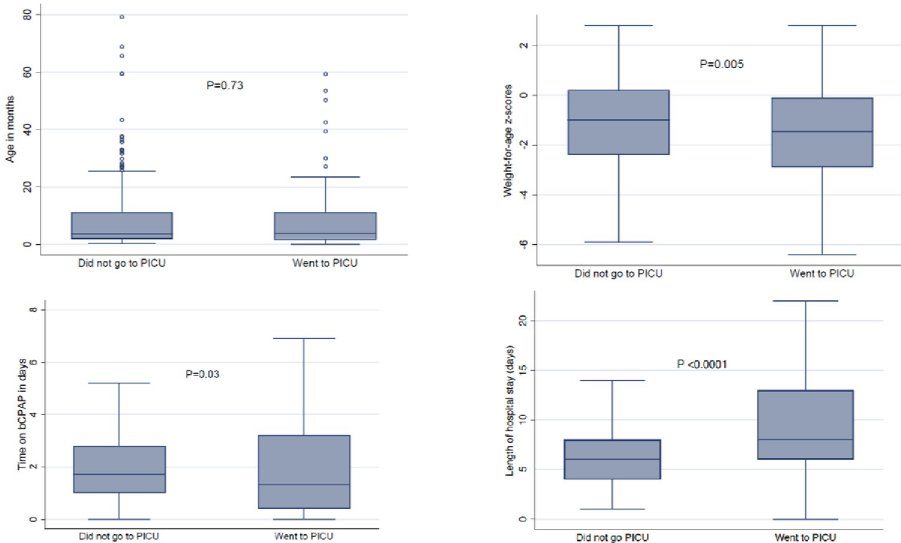
Fig 2. Comparison of children who were admitted to PICU vs. those who were not. PICU-paediatric intensive care unit; bCPAP- bubble continuous positive airway pressure.